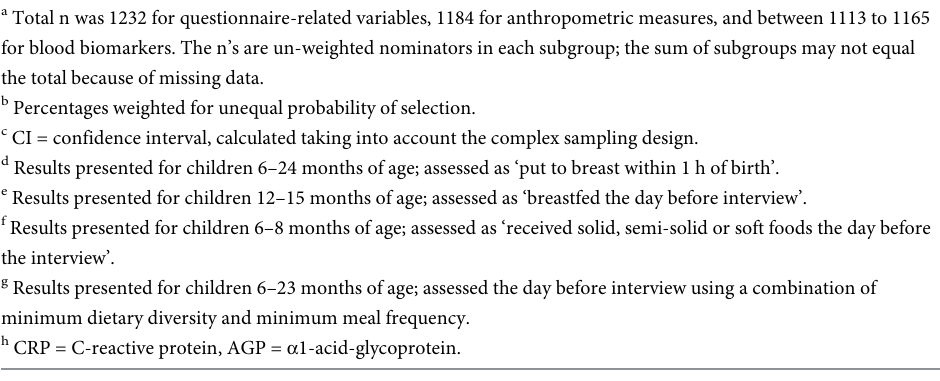
wealth quintile (47.0% in lowest to 13.8% in highest, p < 0.001). Median ferritin concentration was 25.3 μ g/L (IQR: 12.4, 44.3), resulting in 21.5% of PSC with iron deficiency (ID) and 12.2% with iron deficiency anemia (IDA). Similar to anemia, we found the highest prevalence of ID (34.4%) and IDA (22.1%) in 12–23 months old children with a progressive decreased with increasing age (10.2% for ID and 5.0% for IDA at 48–59